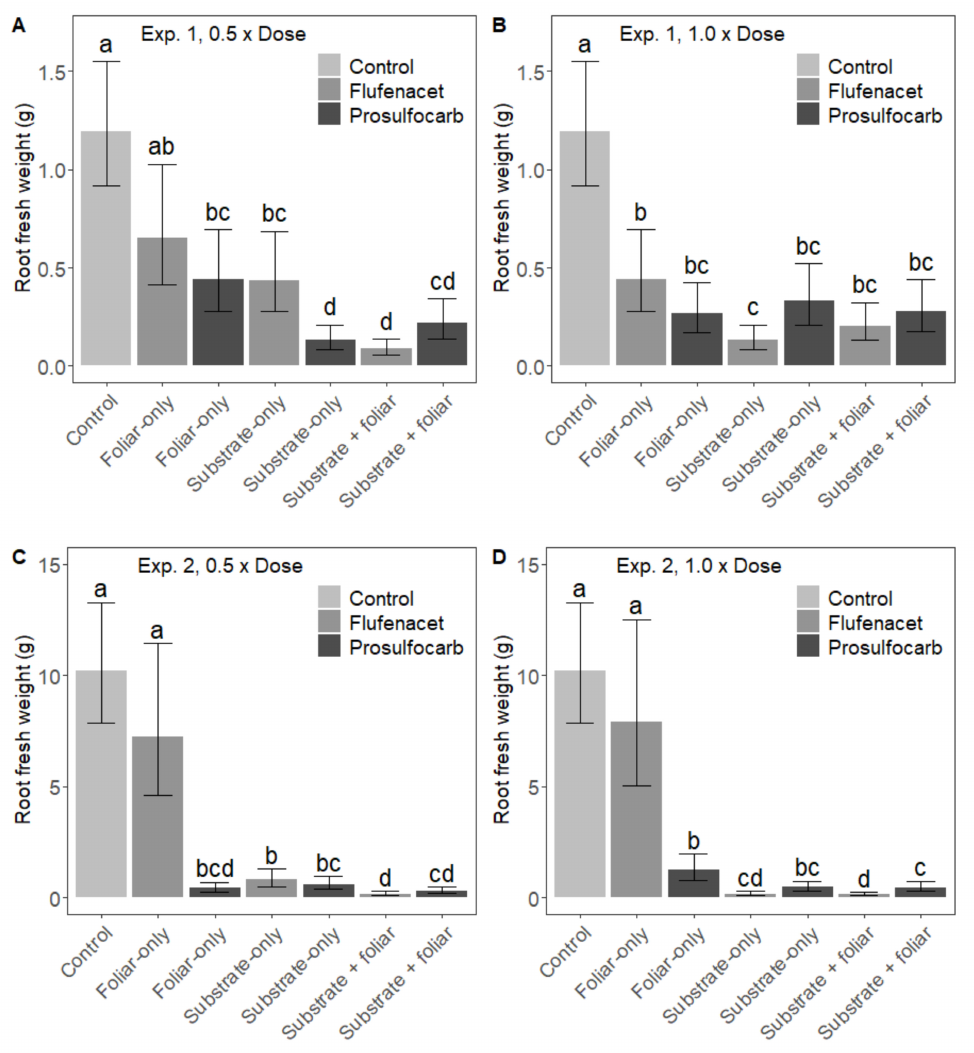
Figure 3. Estimated mean values of the root fresh weights (g) (with error bars representing 95% confidence intervals) after spraying with half (0.5 × dose) and recommended dose (1.0 × dose)